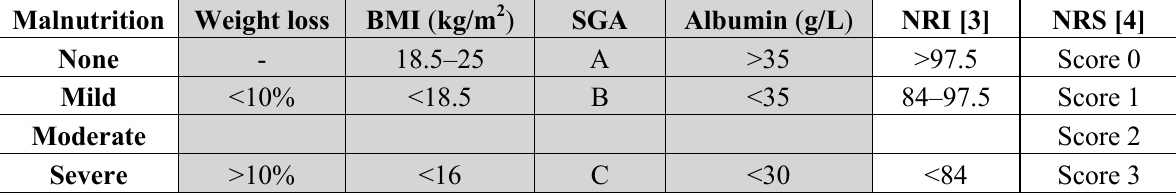
Table 1. Definition of malnutrition. Common screening tools for